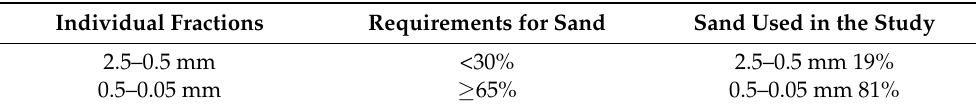
Table 3. The percentages of individual fractions with specifications for quartz sand and of the sand used in this study.